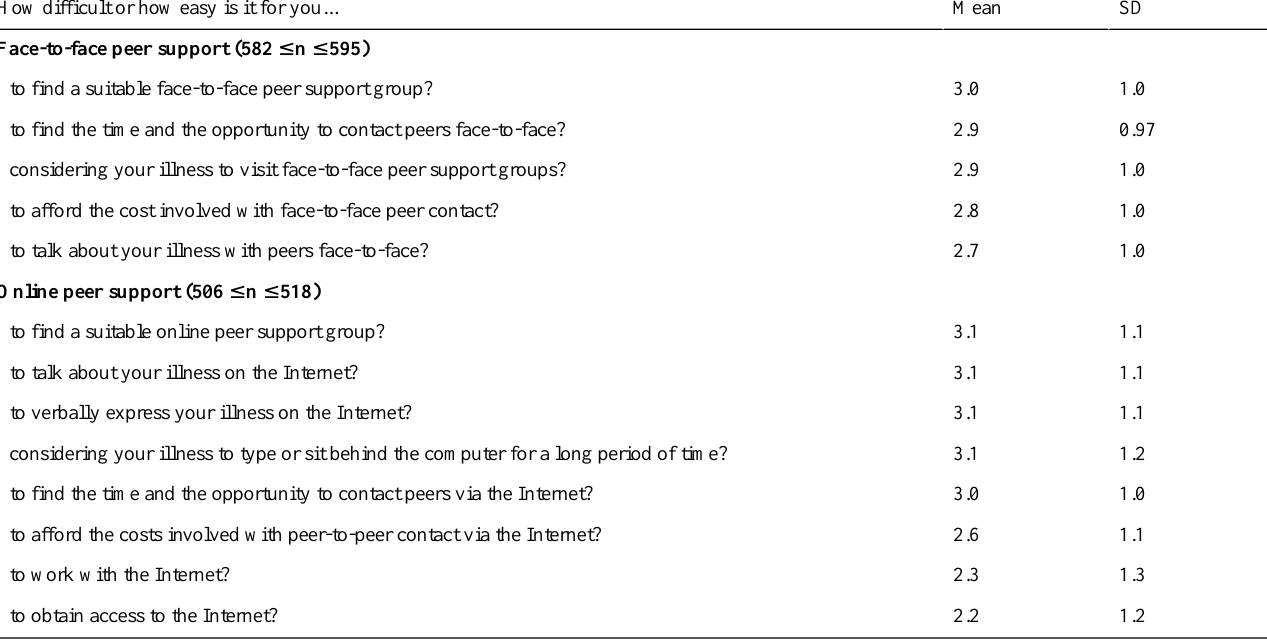
Table 5. Mean item scores (range 1–5) for barriers to peer support SDMeanHow difficult or how easy is it for